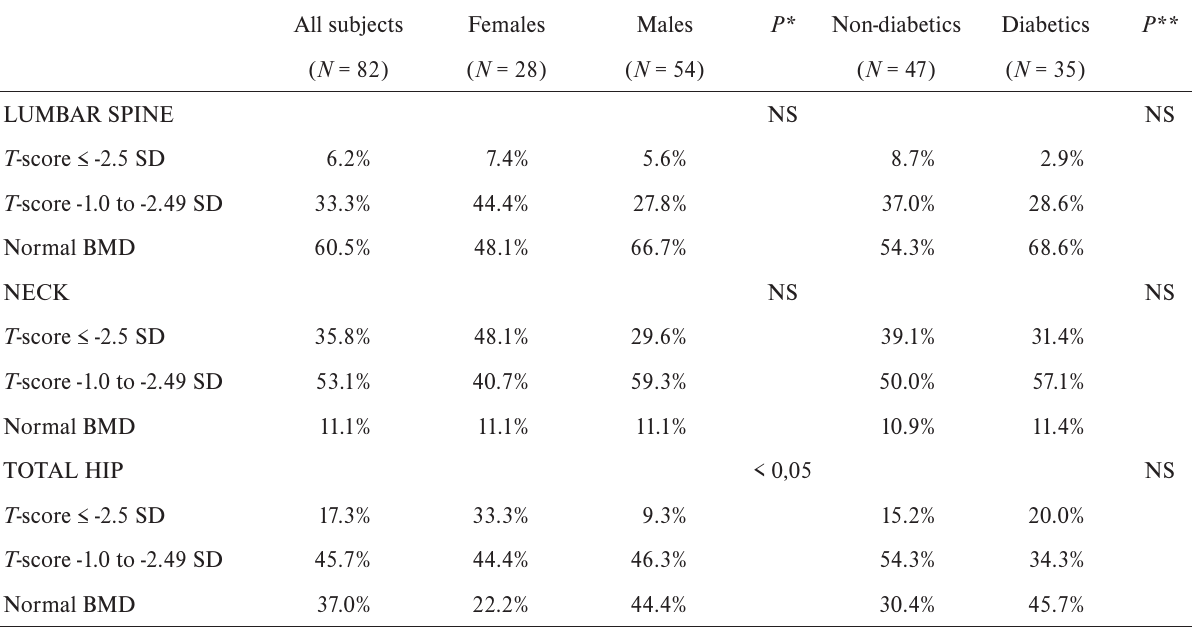
Table 3. Prevalence of T -score values corresponding to osteoporosis and osteopenia for all subjects and for subgroups of females, males, non-diabetics and diabetics.